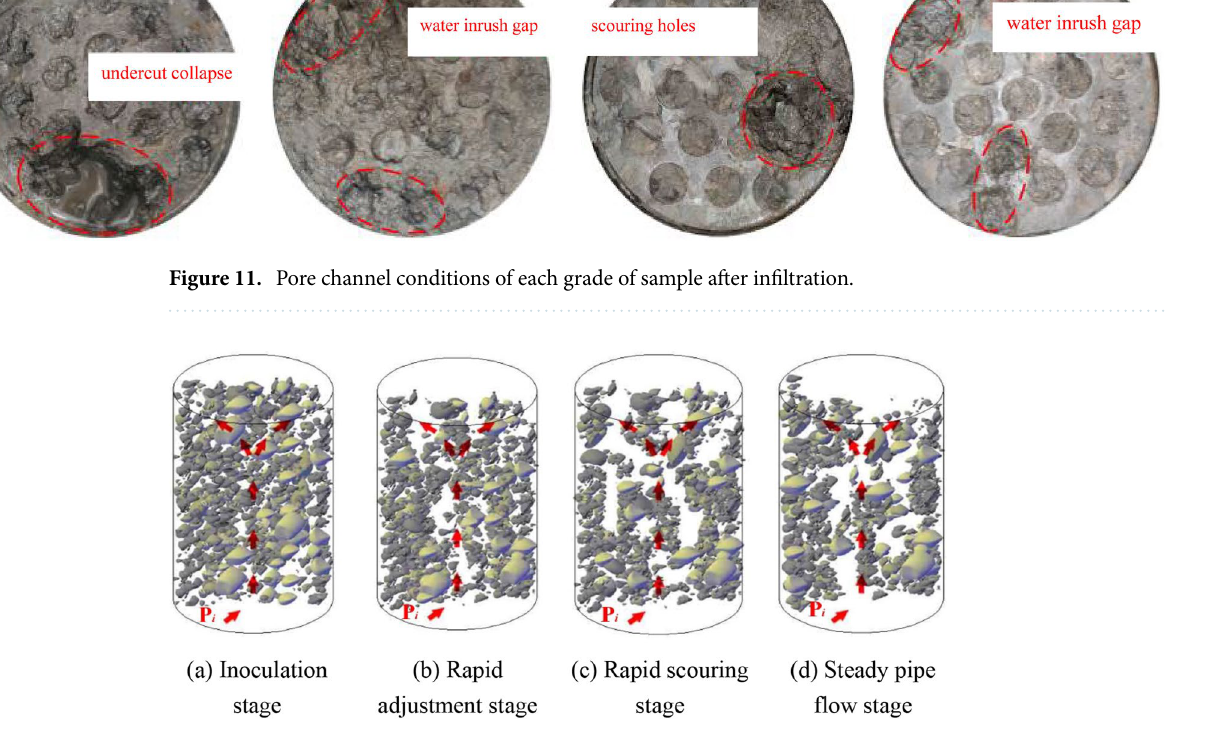
Figure 12. Schematic diagram of the pore penetration process of a filling